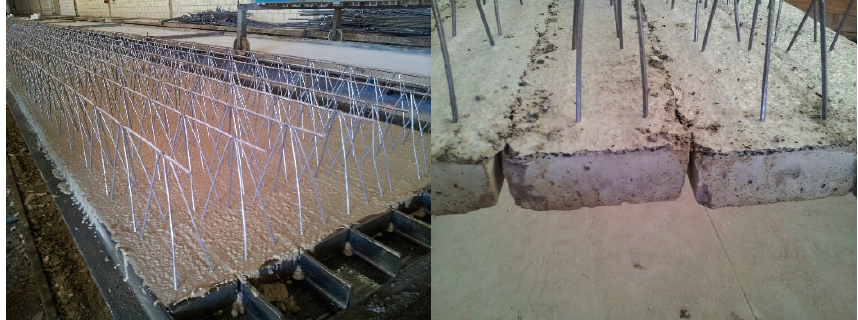
Figure 3. Hollow block manufacturing.